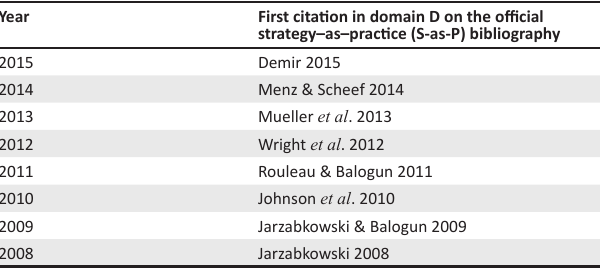
TABLE 2: The list of papers included in the domain D sample.